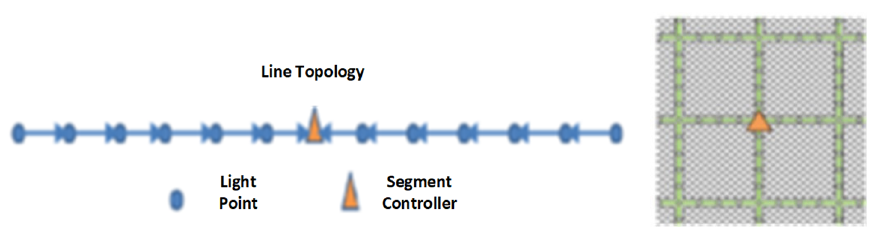
Figure 18. Basic topologies for IEEE 802.15.4g-based Outdoor Lighting Networks (OLNs) evaluation [57]. Table 3. Comprehensive 802.15.4g network testing results [57]. Throughput (KB) Data rates (Kbps)